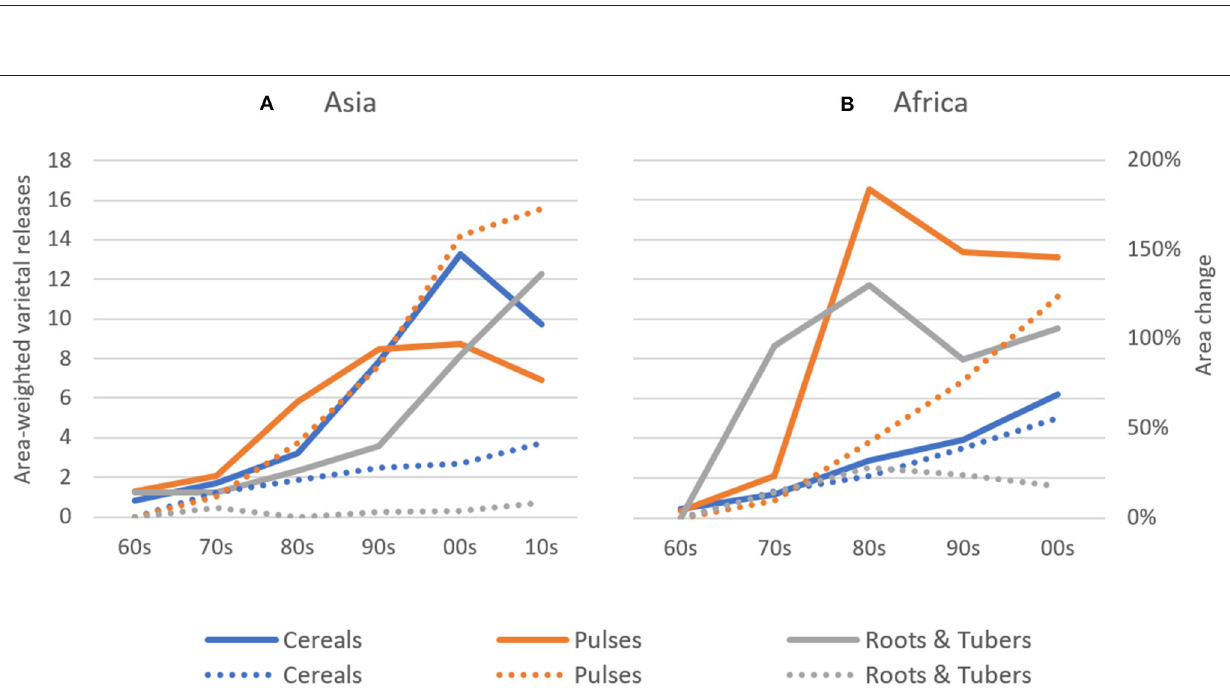
FIGURE 3 | Area-weighted Varietal Releases in Asia and Africa between 1960–2014. Area-weighted varietal releases for cereal, pulse, and root & tuber crops are shown on a 1 release per 100 thousand hectares basis. Explanation on how area-weighted varietal releases were calculated can be found in the Materials and Methods section. Percentage land area changes for crop groups are also depicted (dotted trend lines) taking the 1960s’ observations as base. (A) Asia, (B)